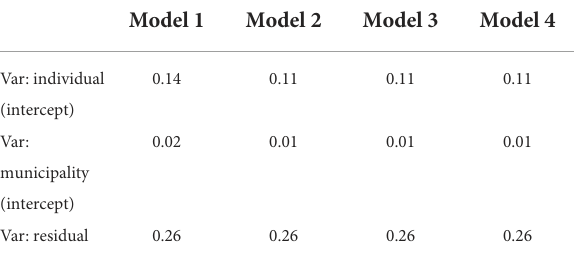
TABLE 6 Multilevel linear regression models for